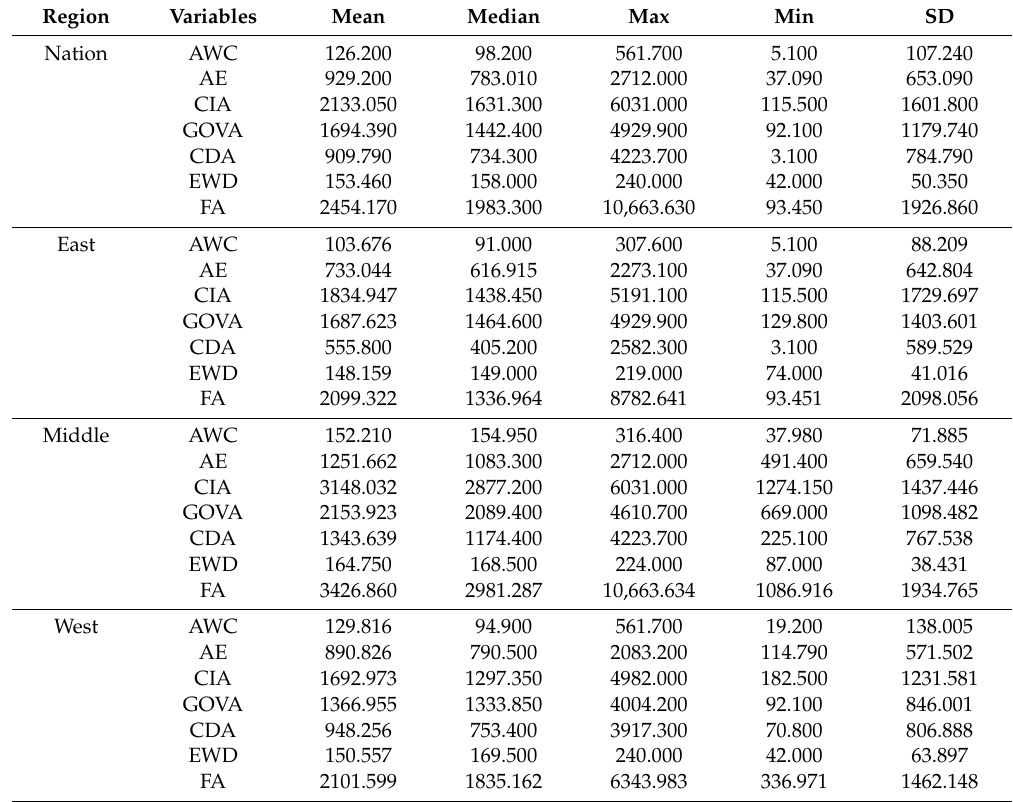
Table 3. Descriptive statistics of the inputs and outputs.